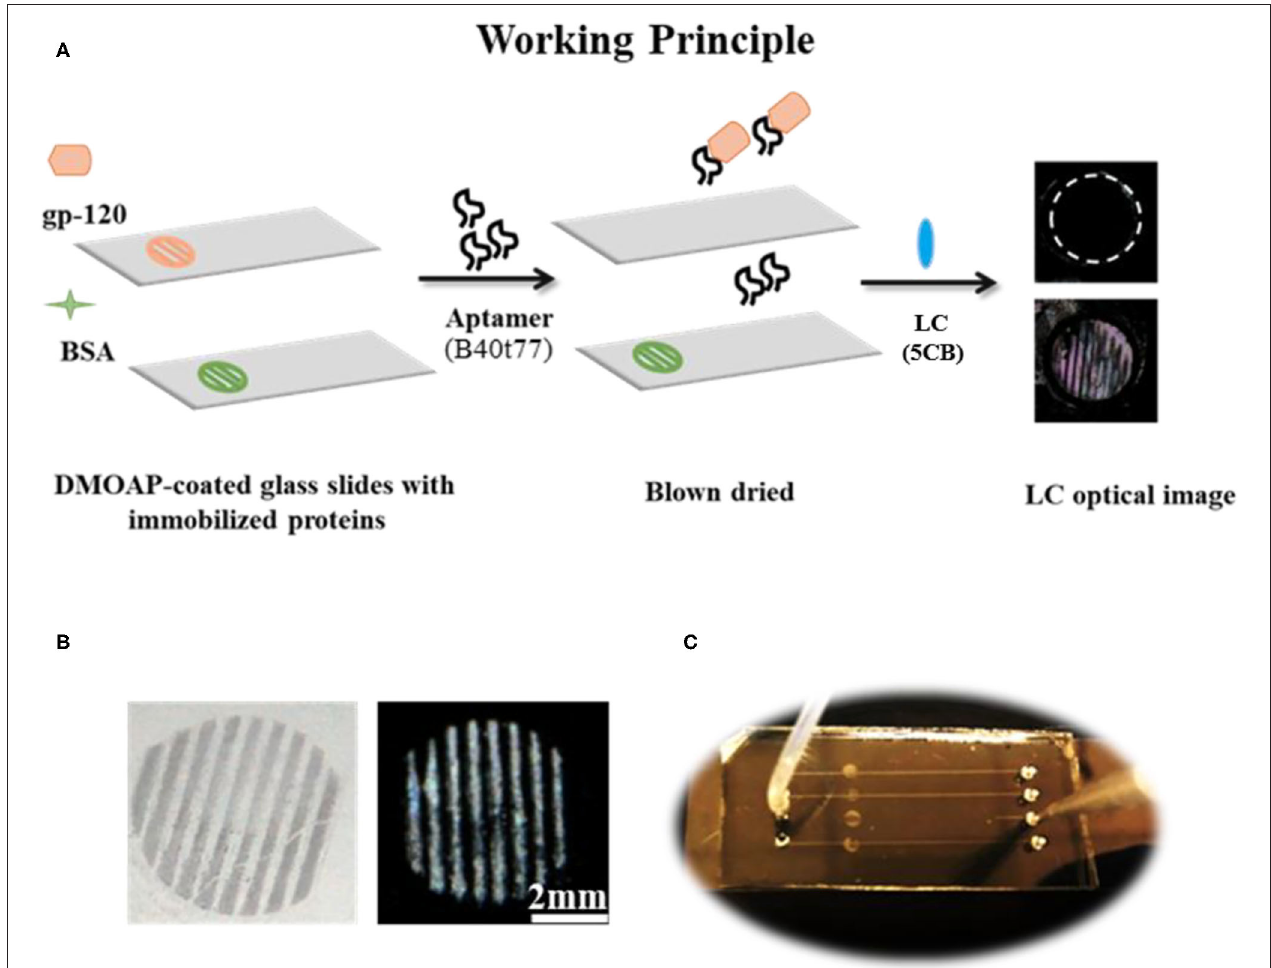
FIGURE 1 | (A) The working principle for the detection of gp-120 by using an RNA aptamer B40t77 and LC. (B) Optical images of surface-immobilized gp-120 (left) and corresponding LC images (right) showing that the pattern of surface-immobilized gp-120 on the glass slide closely ensembles a TEM grid. (C) Top view of a microfluidic device for the proposed binding assay. The inlet of the microfluidic device was connected to a piece of silicon tubing for delivering a solution containing B40t77 at a controlled flow rate.